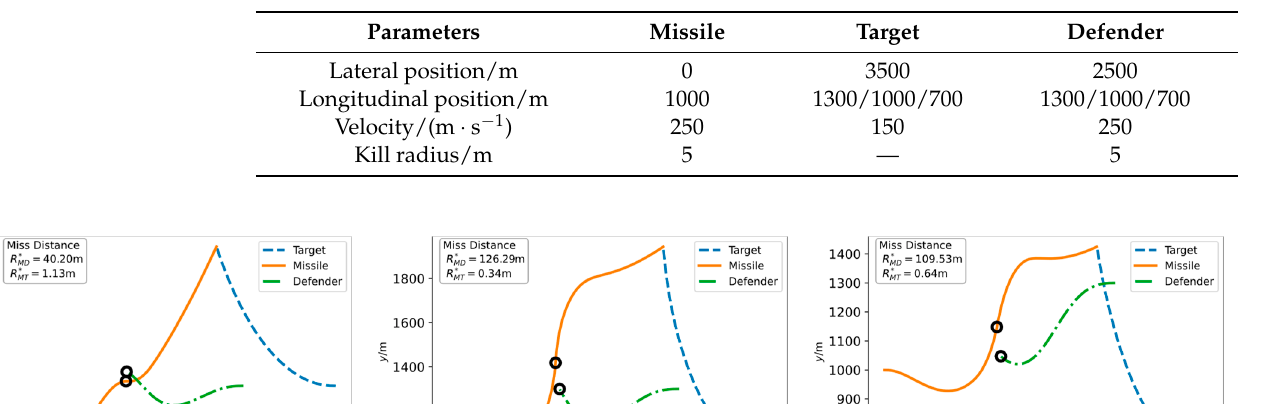
Table 4. Initial parameters for training.